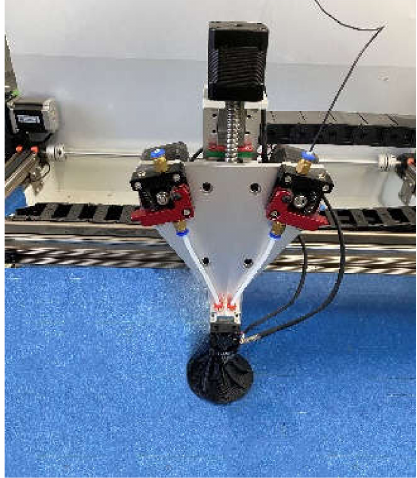
Figure 7. Experimental printing device.